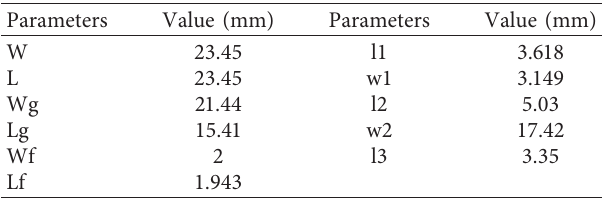
Figure 1: The structure of the proposed meander dipole antenna. Table 1: Designed antenna